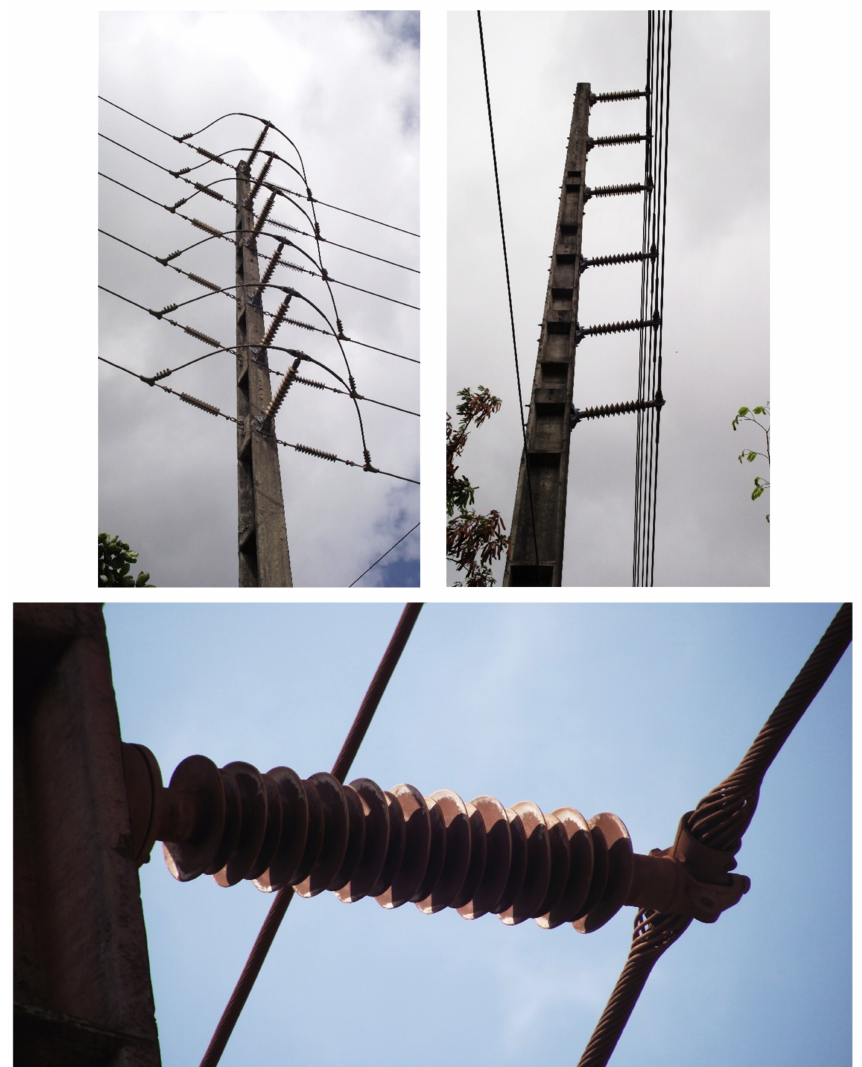
Figure 8. Example of the concrete pole structures of the utility’s system ( top ) and an insulator showing intense surface pollution ( bottom ). These photos show concrete double T-profile poles, which constitute a major part of the utility’s system. The structures depicted in the photos comprise a double circuit three phase line. A major part of the polymeric insulators used in the system are of line post, strain, or suspension type. The objects of study of this research are the partial discharge signals collected, both in the field and in laboratory, from polymeric insulators like